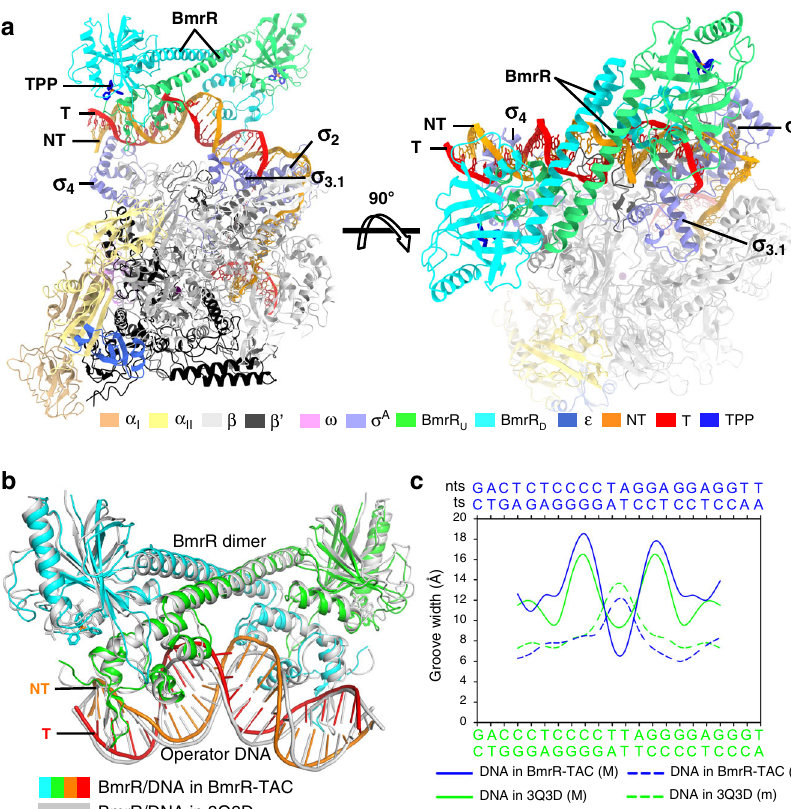
Fig. 2 The overall structure of BmrR-TAC. a The top and front view-orientations of the BmrR-TAC structure. b Structure superimposition of BmrR/DNA in BmrR-TAC and BmrR/DNA in the crystal structure of a puromycin-bound BmrR/DNA complex (PDB: 3Q3D). c Major (M) and minor (m) groove widths of BmrR operator dsDNA in the BmrR-TAC structure and BmrR/DNA binary